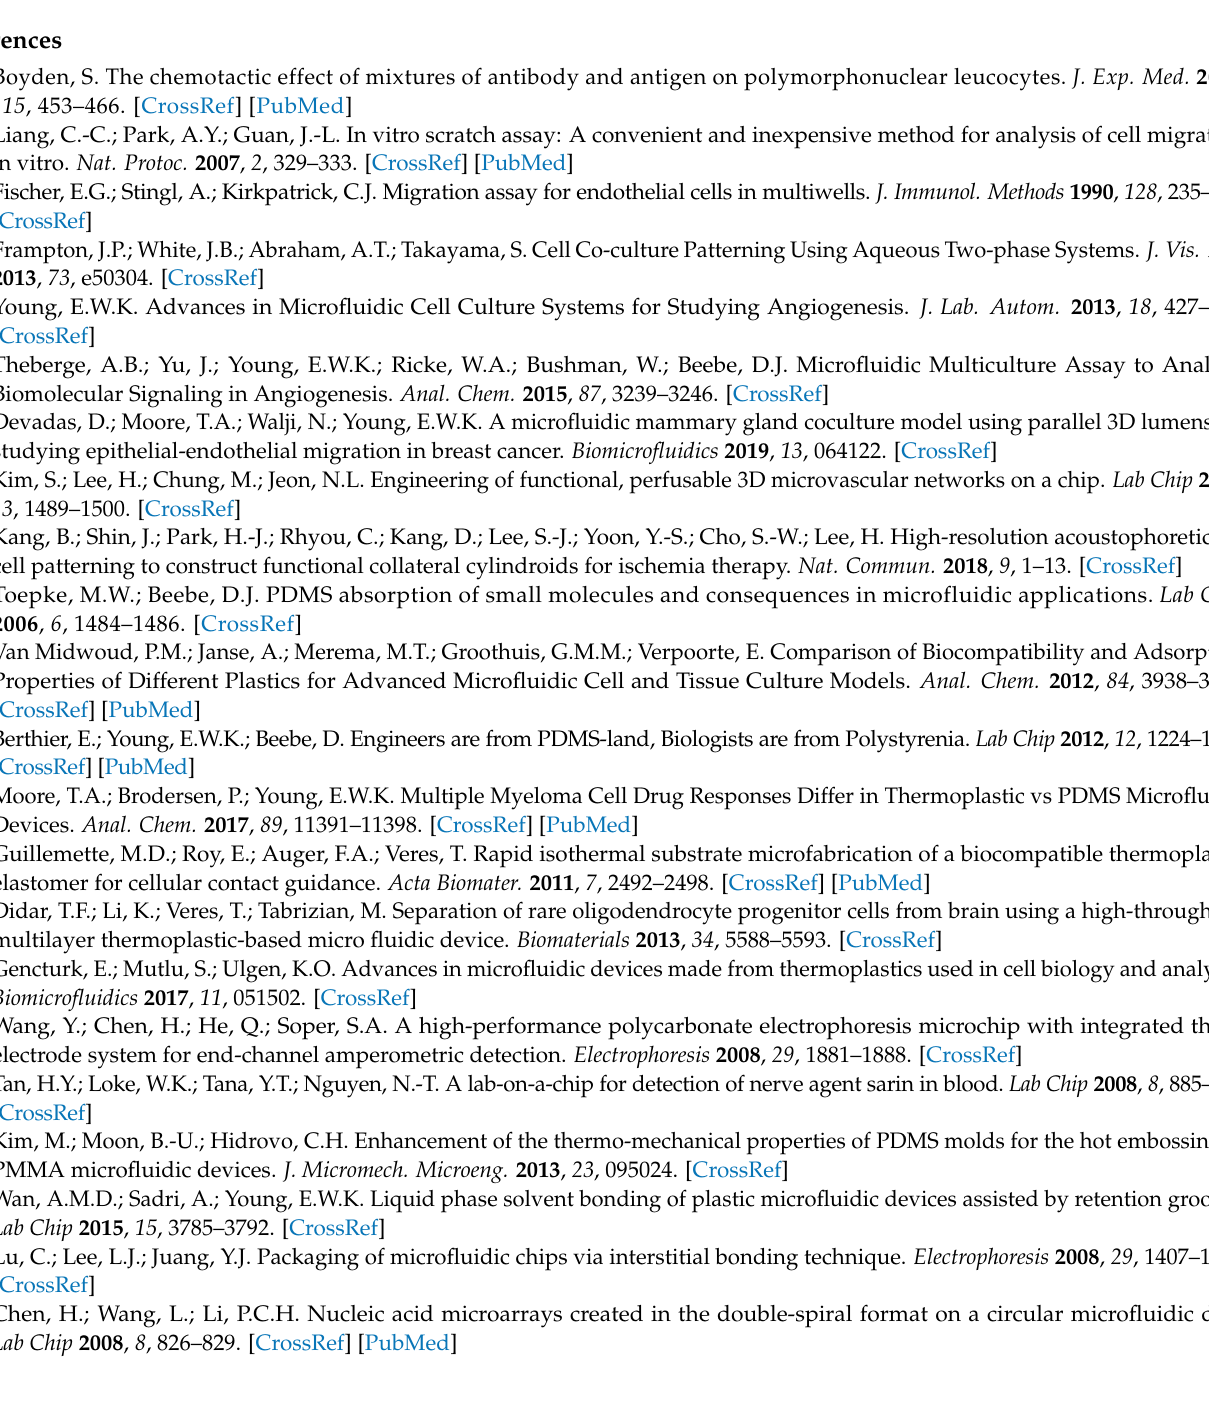
dashed line represents a plot line of the fluorescent intensity. The scale bar shows 500 µ m. (d) The plot graph shows a significant difference of the fluorescent intensities of PDMS and TPE channels. Thus, we confirmed that TPE has less protein adsorption issues than